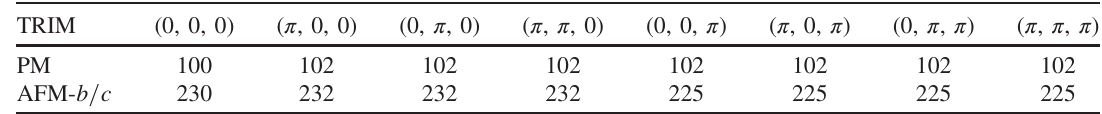
TABLE I. Numbers of occupied bands of odd parity at the eight TRI points in the PM and AFM- b= AFM- c phases of EuSn 2 As 2 ,